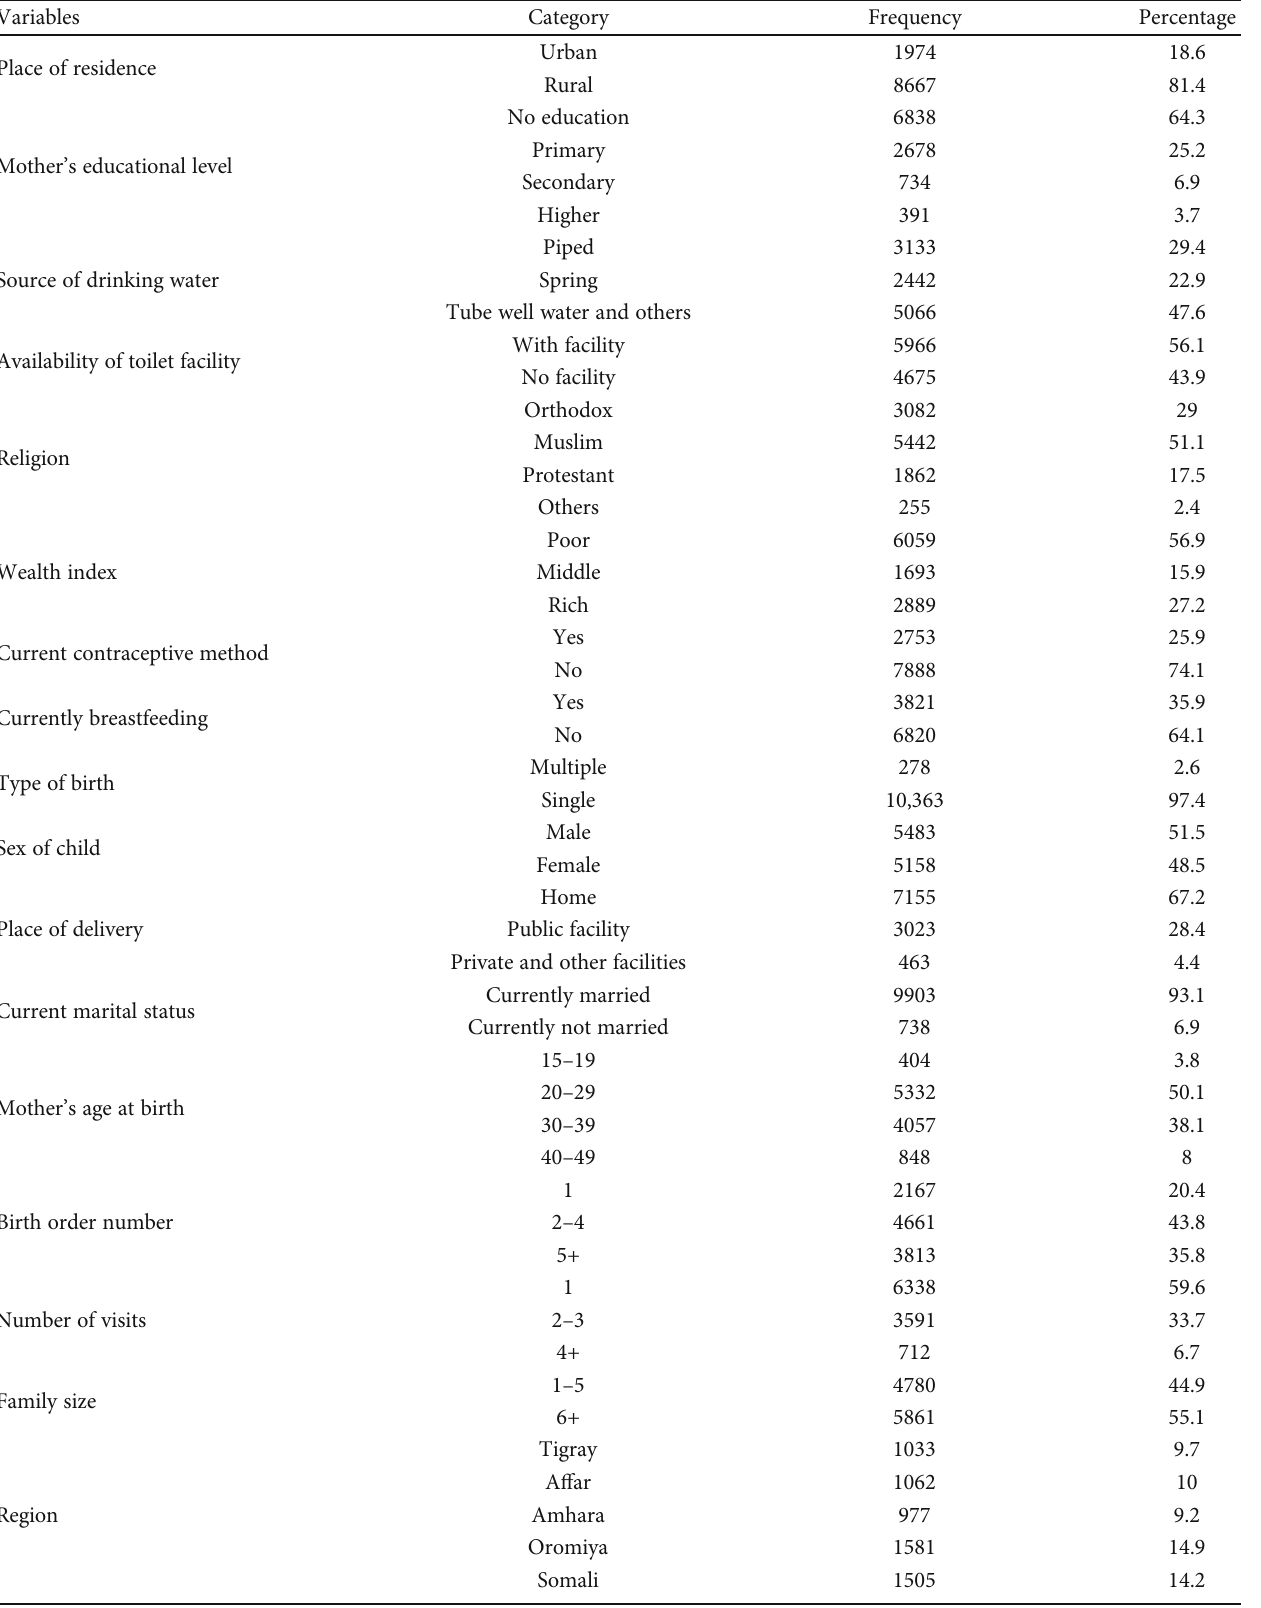
Table 1: Socioeconomic, biodemographic, environmental, and maternal health care variables determining U5CM in Ethiopia,